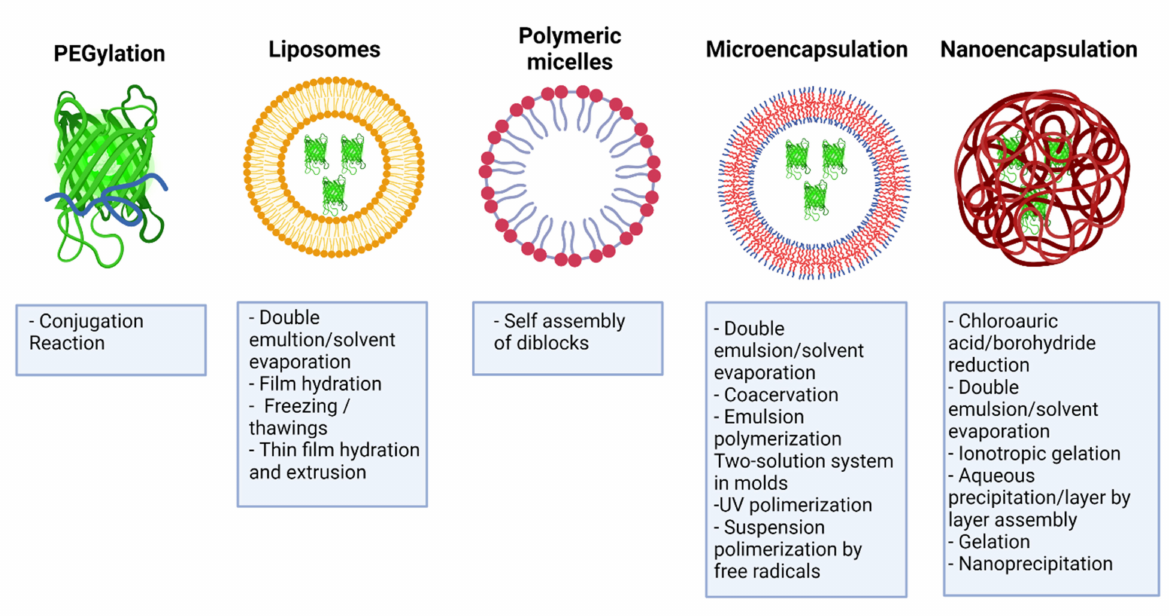
Figure 4. Encapsulation methods and IFN-delivery system. Summary of the different transport systems for type I and II IFNs, including PEGylation, liposomes, micellar systems, self-assembled nanostructures, microparticles, and nanoparticles. Created with